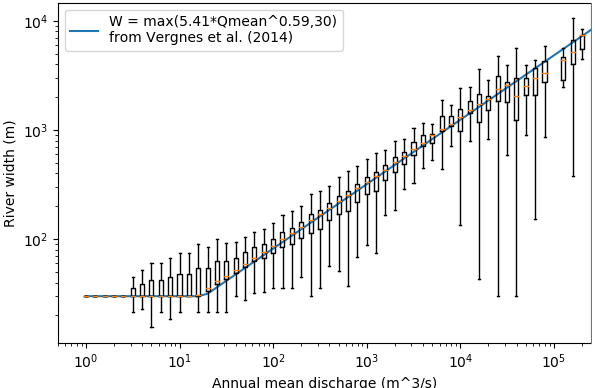
Figure 10. Distribution of river width from GRWL (Allen and Pavelsky, 2018) with respect to the annual mean discharge. The solid blue line represents the river width derived from the empir- ical relationship proposed by Vergnes et al.